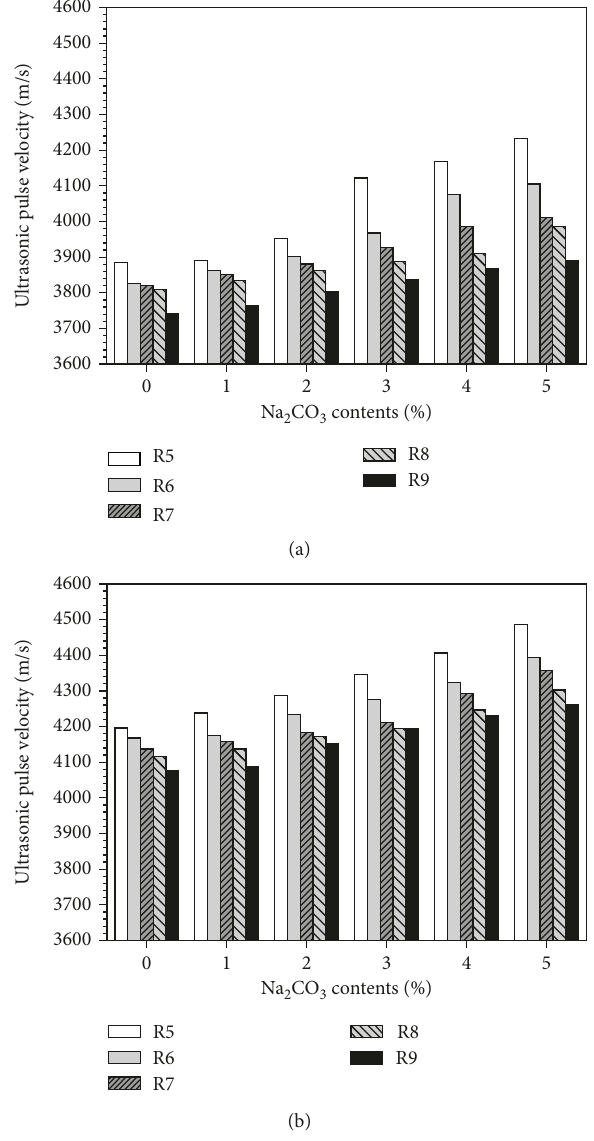
Figure 5: Ultrasonic pulse velocity (UPV) for HVSC pastes con- taining Na 2 CO 3 at (a) 3 days and (b) 28